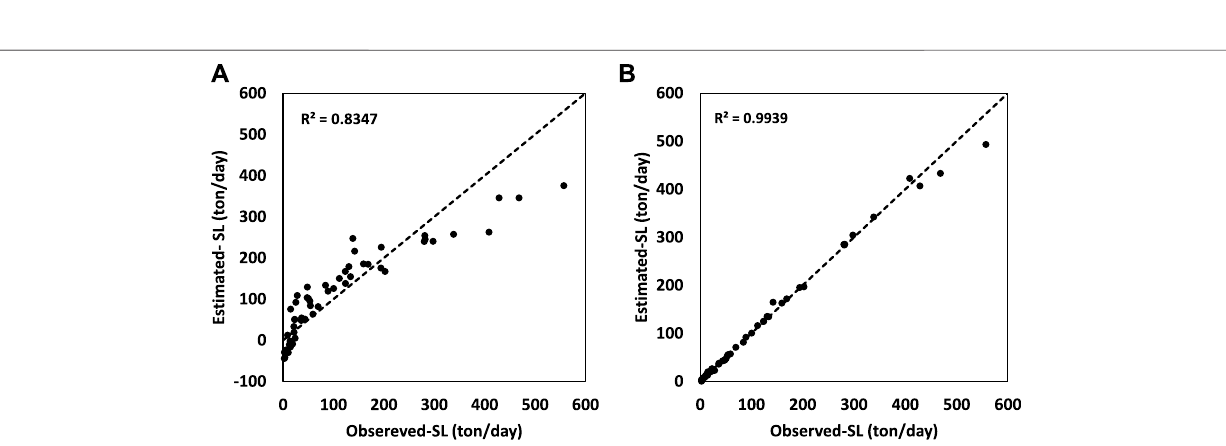
FIGURE 5 | Results for ANFIS and ANFIS-ACOr in the combined input of Q+CM, (A) SL predicted by ANFIS in test mode, (B) SL predicted by ANFIS-ACOr in test mode.